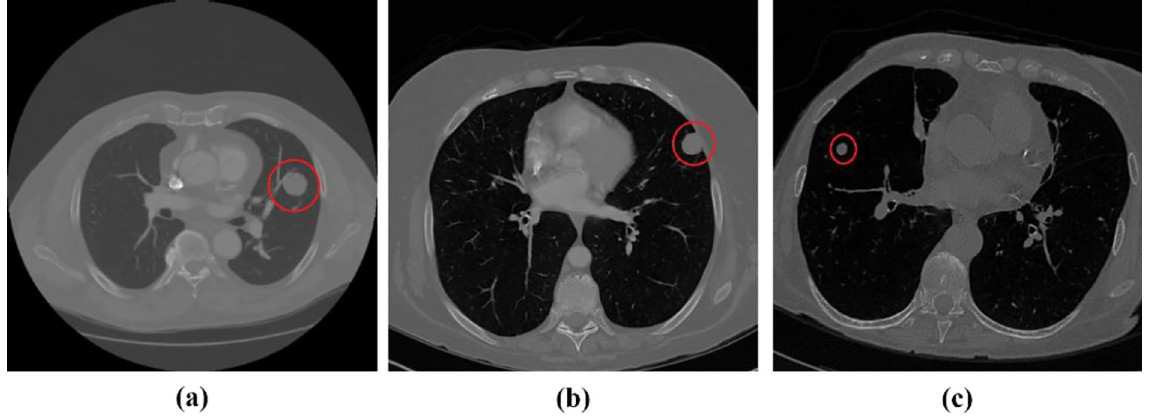
Figure 1. Different Nodule Types ( a ) Juxta-Vascular Nodule ( b ) Juxta-Pleural Nodule.( c ) Well-Circumscribed nodule 4